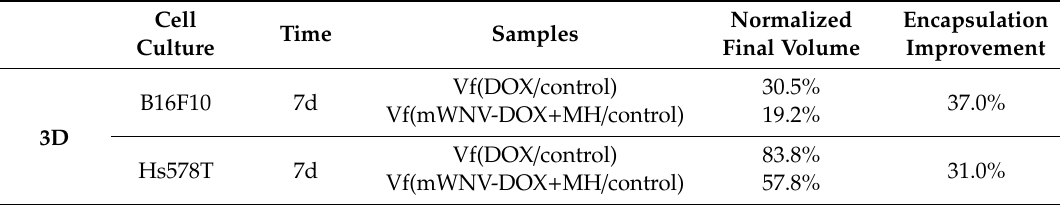
Table 2. Summary of the IC 50 , volume changes and encapsulation improvement (normalised volume values of MCTSs treated with mWNVs-DOX and MH with respect to the volume of treatments without MH, and expressed in %) obtained from 3D tests on the di ff erent cell lines considered for this